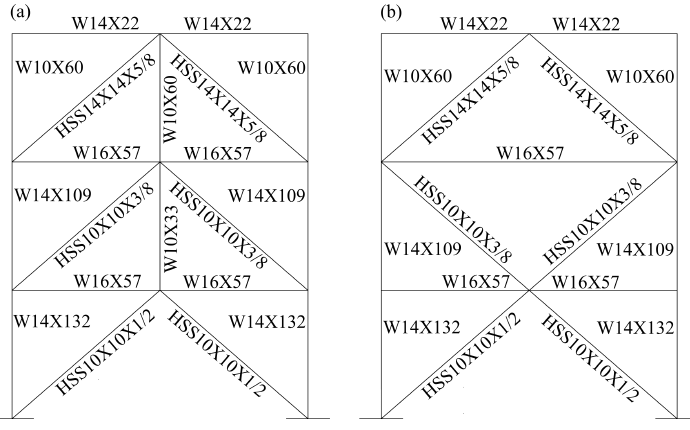
Figure 5. Configuration of ( a ) the chevron-braced frame and ( b ) the cross-braced frame. All the loads (dead and live load) acting on the different floor and their distribution are obtained from Appendix B in FEMA 355C [32]. The self-weight of the steel here is assumed to be 0.622 kN/m 2 [32]. The given loading definition is used to estimate the seismic mass of the structure, which has values of 10,155 kN, 9386 kN, and 9386 kN for the mass of roof, third floor, and second floor, respectively. The FEMA guidelines are used to calculate the lateral load acting on this system. The structure modeled here is assumed to be located in Los Angeles with site class